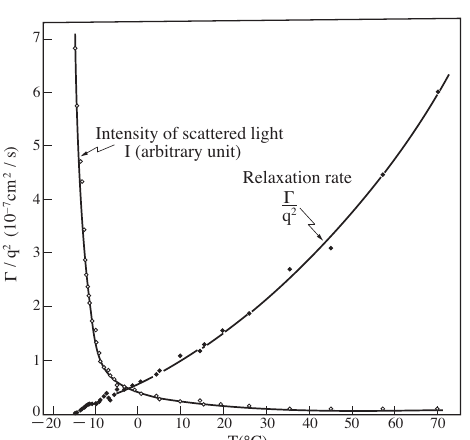
Figure 7. The critical slowing down in poly (acrylamide) gel observed by the light scattering mea- surements. Reproduced with permission from Ref. [8]. © (1986) The Physical Society of